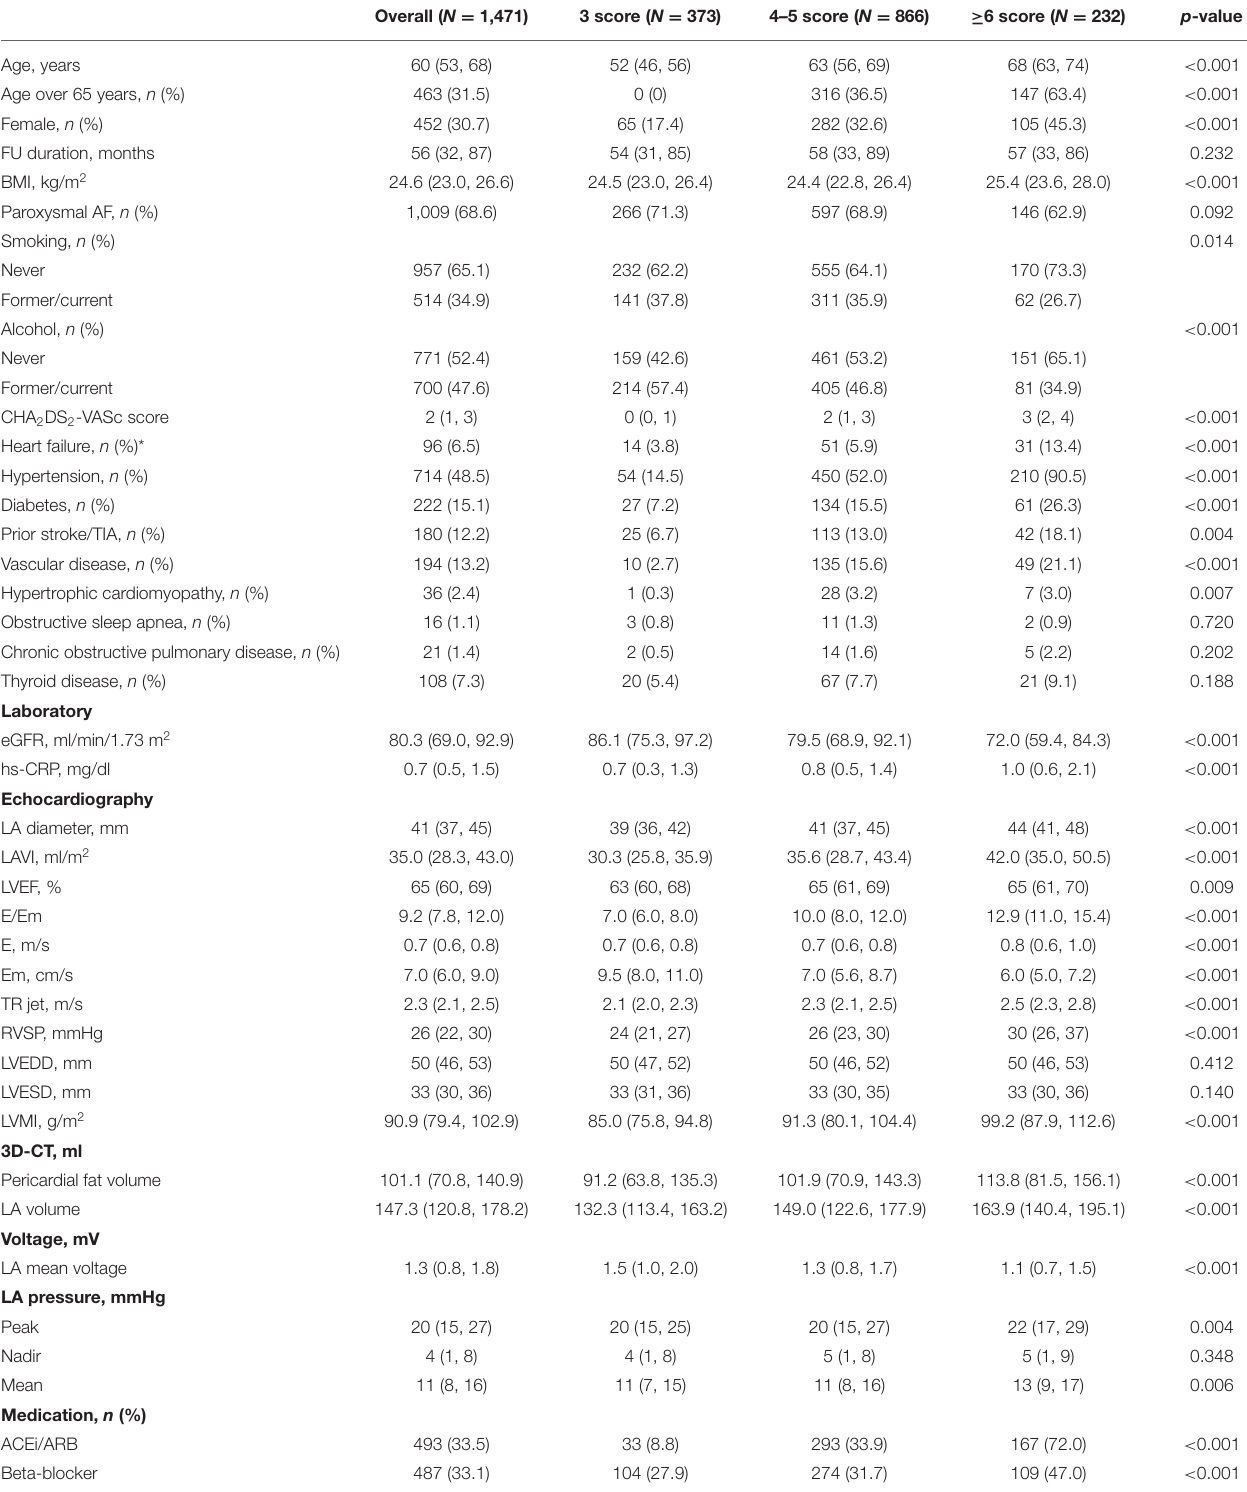
TABLE 1 | Baseline characteristics according to the baseline H 2 FPEF score stratification in atrial fibrillation (AF) patients with a normal left ventricular ejection fraction (LVEF). Overall ( N = 1,471) 3 score ( N = 373) 4–5 score ( N =